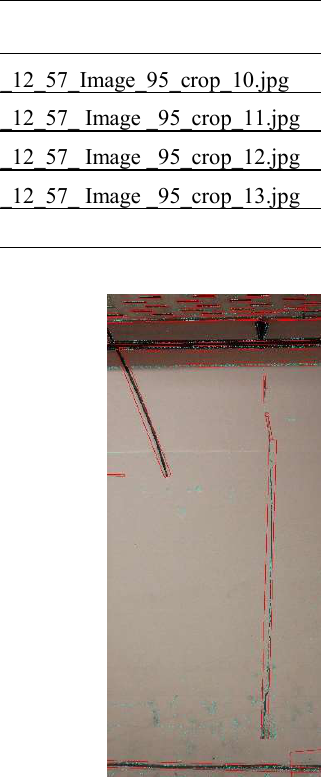
Table 3: Example of output